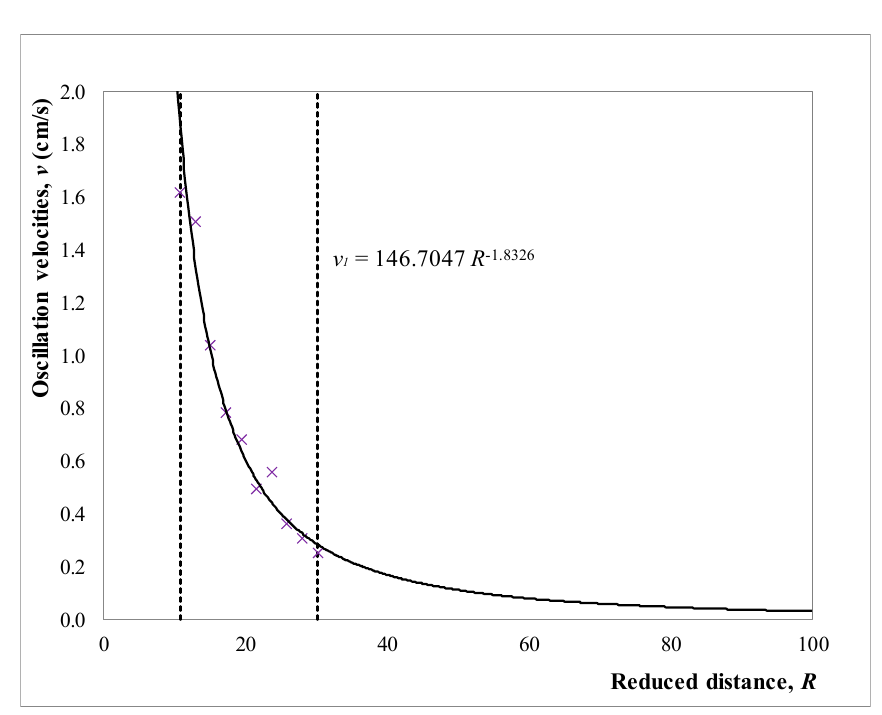
Figure 2. Minerals 2018 , 8 , x FOR PEER REVIEW